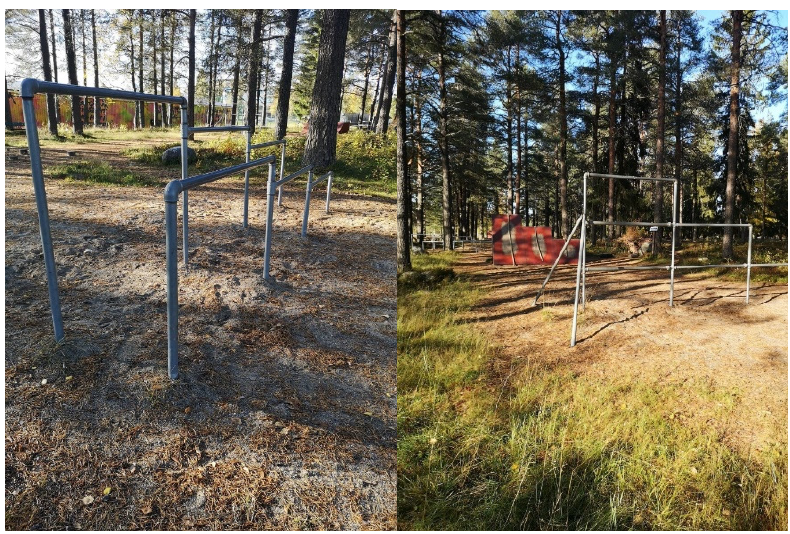
Figure 2. A military training course by I20, a military regiment in Umeå, Sweden.